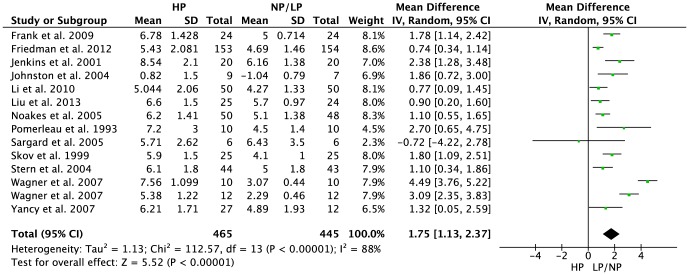
Forest plot showing pooled MD with 95% CI for serum urea (mmol/l) of 13 randomized controlled HP diet trails.For each high protein study, the shaded square represents the point estimate of the intervention effect. The horizontal line joins the lower and upper limits of the 95% CI of these effects. The area of the shaded square reflects the relative weight of the study in the respective meta-analysis. The diamond at the bottom of the graph represents the pooled MD with the 95% CI. HP, high protein; NP/LP, normal protein/low protein.